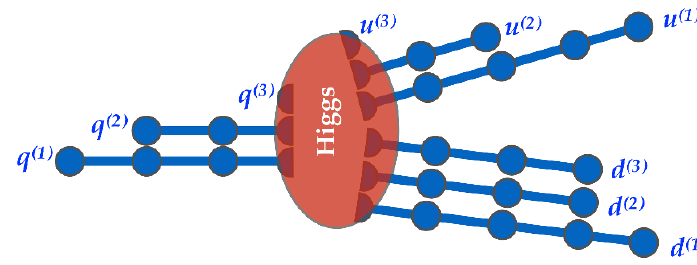
Figure 4 . The vector-like chains (blue) for the inverted FN model with G FN = U(1) 3 fermions are on the zero node, denoted by the red ellipse, which also contains the